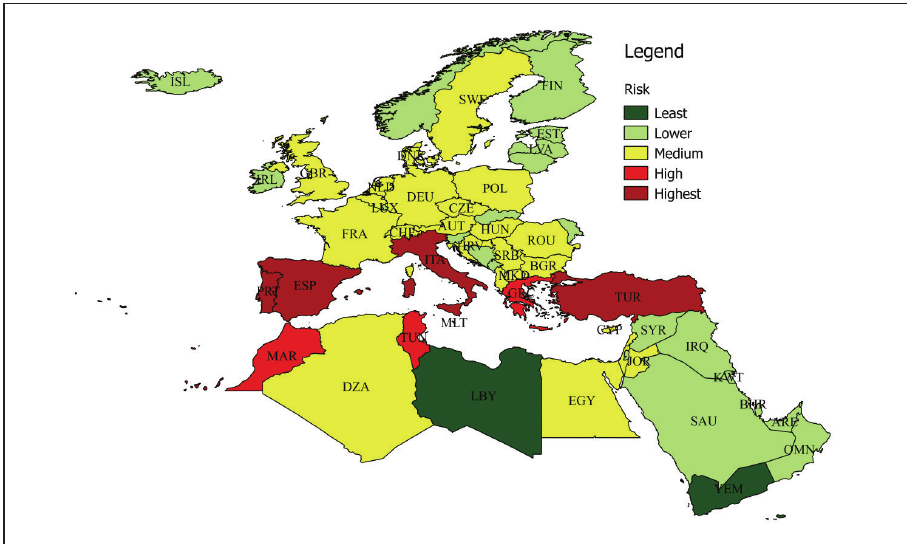
Figure 7. Overall rank categorization of Europe and MENA region according to exposure to invasion by Xf with respect to combined all entry, establishment and spread risk drivers and using the matrix of Early et al.